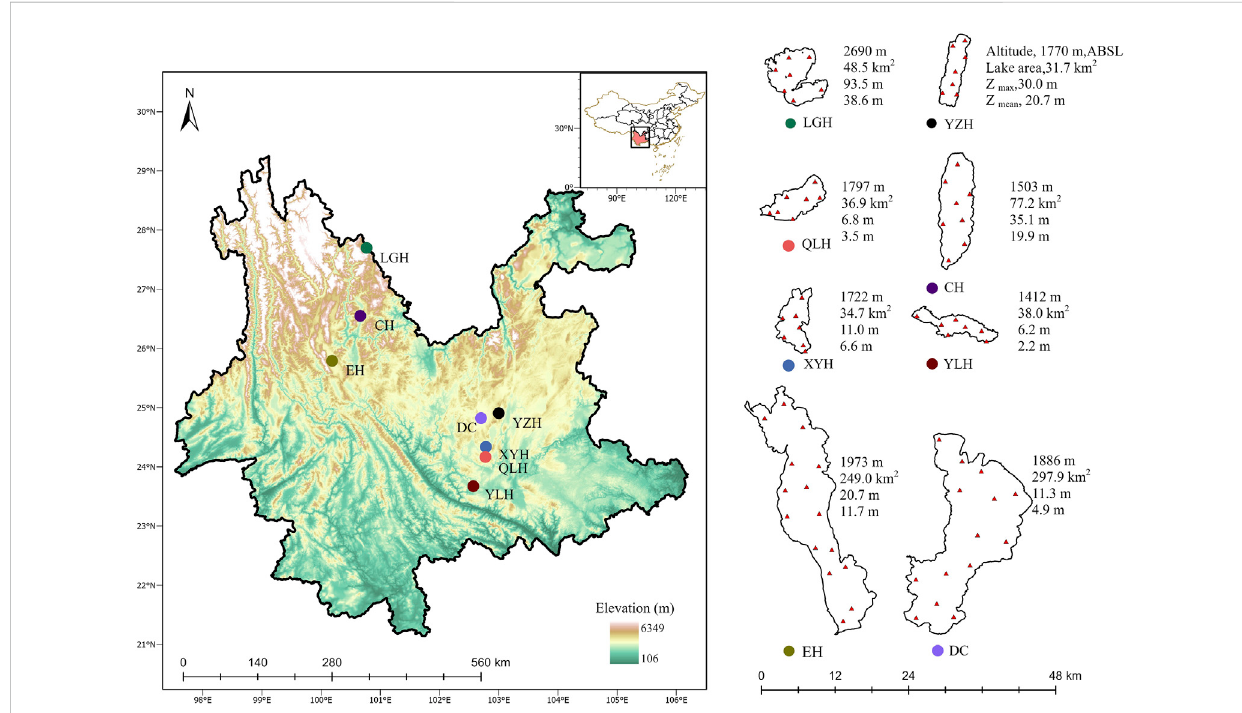
FIGURE 1 Location and sampling sites of the studied lakes. Panels show the geographical location (left) and the basic lake characteristics and sampling sites (right). Z max , maximum depth; Z mean , mean depth. LGH, Lake Luguhu; CH, Lake Chenghai; YZH, Lake Yangzonghai; EH, Lake Erhai; XYH, Lake Xingyunhu; DC, Lake Dianchi; YLH, Lake Yilonghu; QLH, Lake